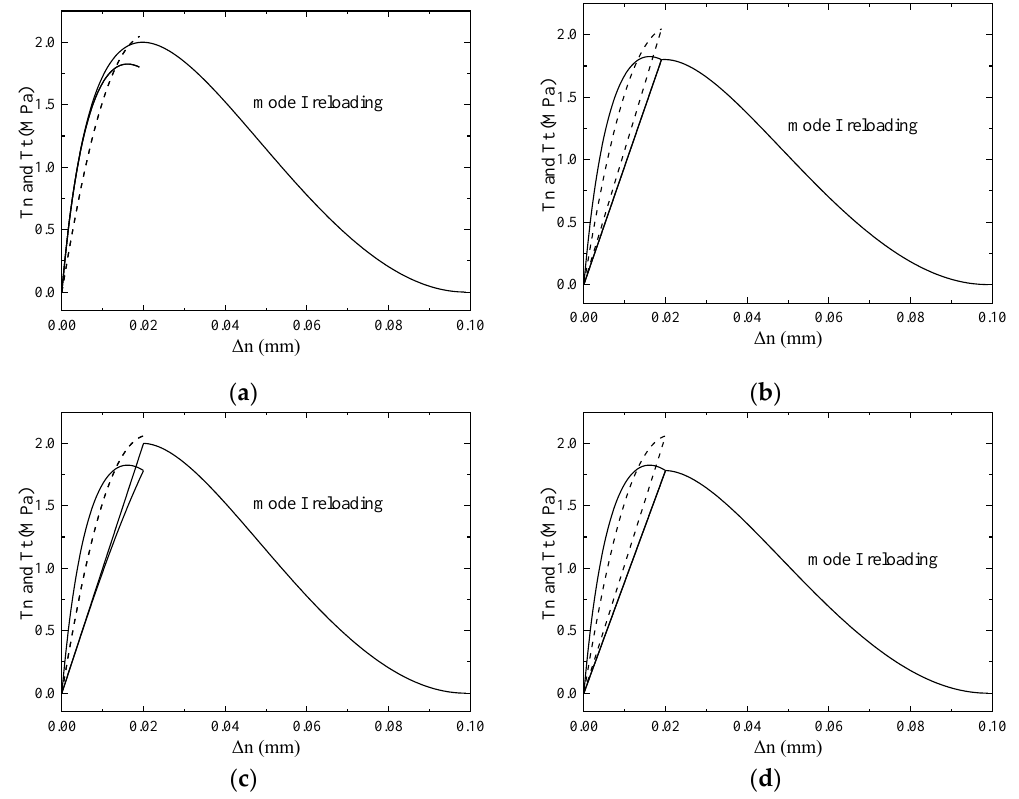
Figure 16. Variations of the traction components 𝑇 𝑛 (solid lines) and 𝑇 𝑡 (dashed lines) during the process of proportional loading/unloading and mode I reloading, for a proportional loading amplitude of Δ = 0.019 mm ( a , b ); or Δ = 0.020 mm ( c , d ). Model (i) ( a,c ); model (ii) and model (iii) ( b,d ).